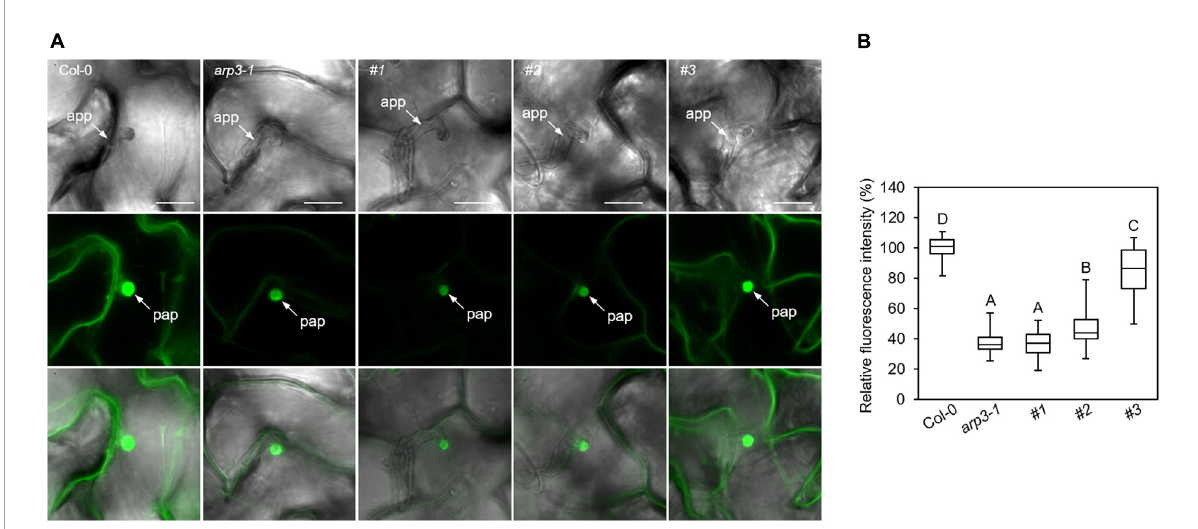
FIGURE5 Clustered regularly interspaced short palindromic repeats (CRISPR)-derived variants of ARP2 exhibit different levels of GFP-PEN1 accumulation at penetration sites upon powdery mildew fungus Bgh attack. (A) Deposition of GFP-PEN1 at the Bgh -attempted penetration sites. Leaves of 4 weeks old from wild-type Col-0 , arp3-1 T-DNA Salk line, and T1 generation of CRISPR transgenic individuals #1, #2, and #3 in the GFP-PEN1 expressing background were inoculated with Bgh and examined for GFP-PEN1 signals by confocal microscopy at 24 hpi. Bars, 20 µ m. Micrographs were captured with the same imaging parameters. (B) Boxplots display relative fluorescence intensity of GFP-PEN1 at the papillae in the indicated genotypes. Quantitative analysis was performed for 30 cells per genotype. Different letters indicate statistically significant differences, as determined by one-way ANOVA with Tukey’s HSD ( p < 0.01). app, appressorium; pap,